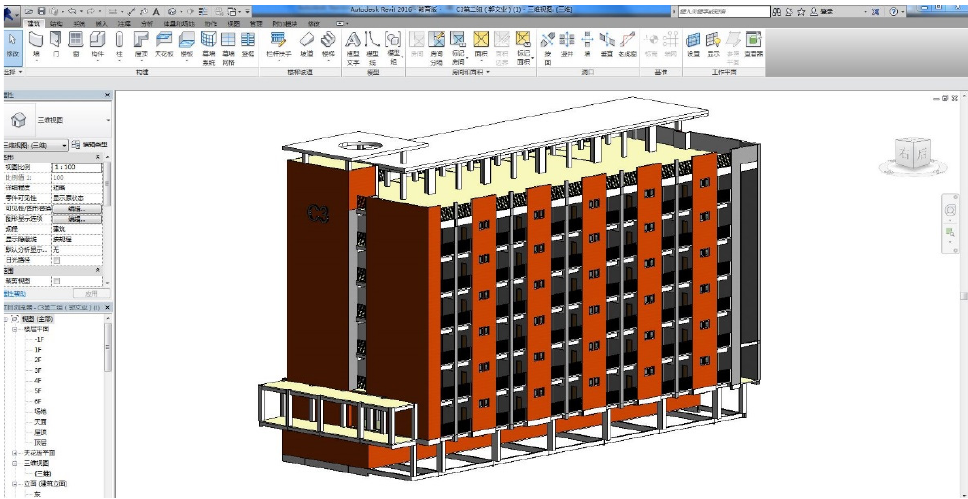
Figure 12. BIM model of a student dormitory building.